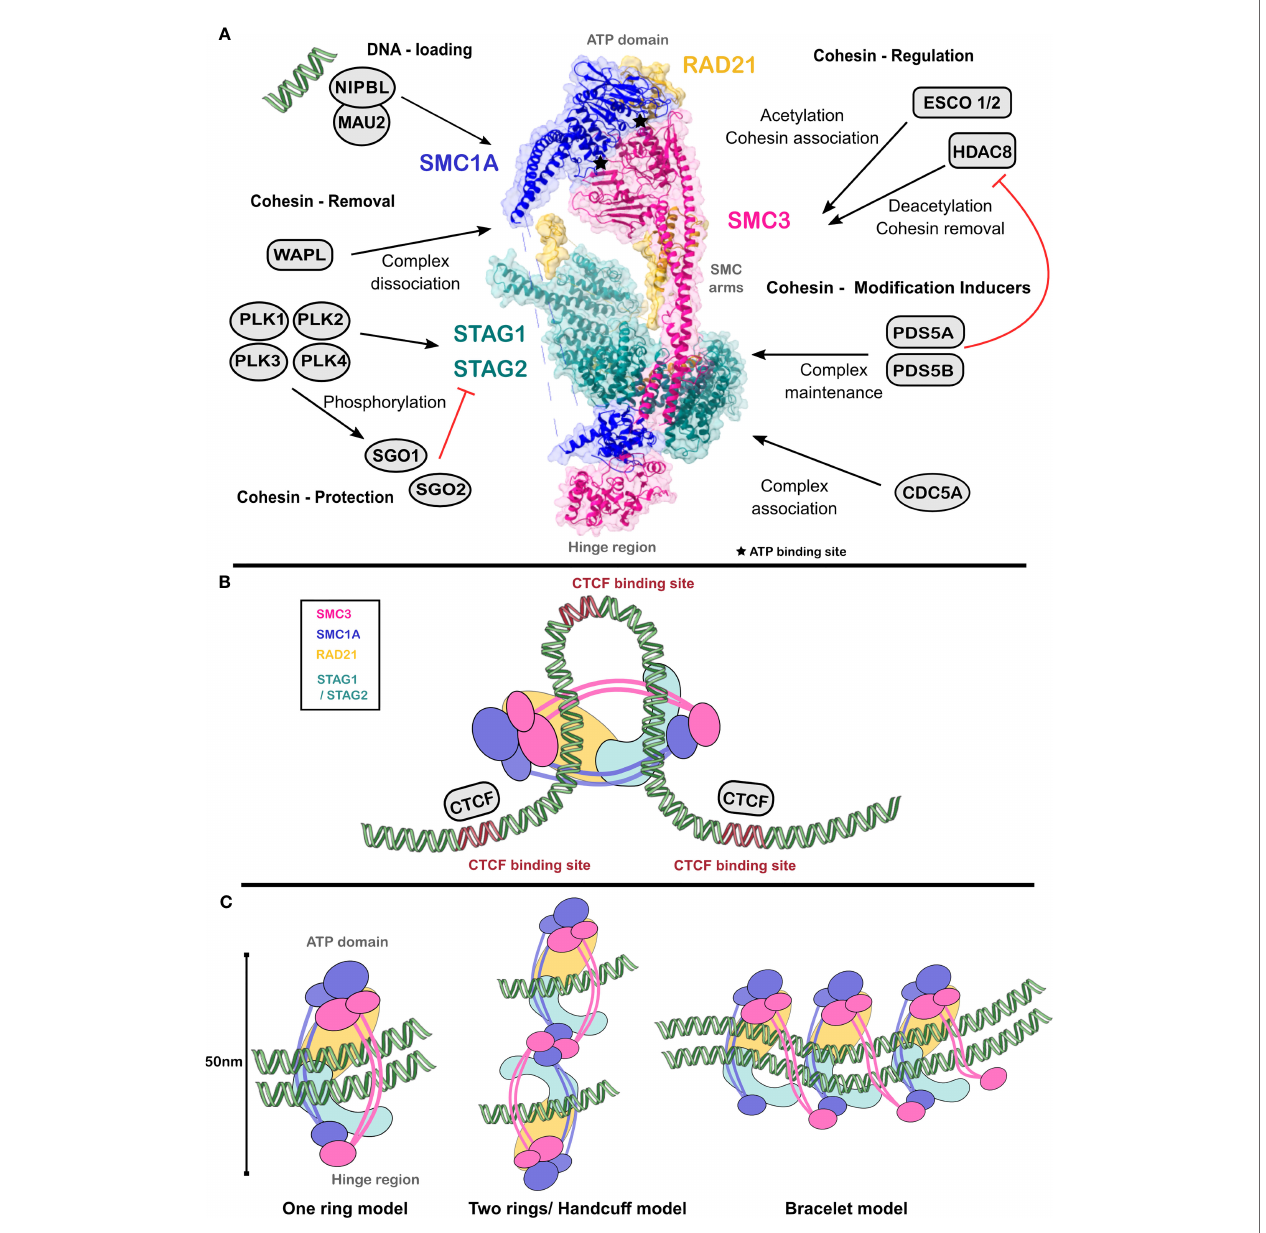
FIGURE 1 | Cohesin complex enables chromatin architecture. (A) SMC1 and SMC3 heterodimer forms the ‘ hinge ’ region and the ATPase domains at either ends. RAD21 and STAG1/STAG2 complete the cohesin complex. Several proteins dynamically bind to the cohesin complex and regulate its function. Structure of cohesin complex was obtained from PDB ID 6wg3 (10). (B) Cognate binding sites of CTCF (in purple) constrain cohesin translocation, thus forming chromosomal loops. (C) Mechanistic models of cohesin action dynamically exist within a cell to enable cohesin-mediated chromatin organization. Figures were created using Chimera, Inkscape and the Servier Medical